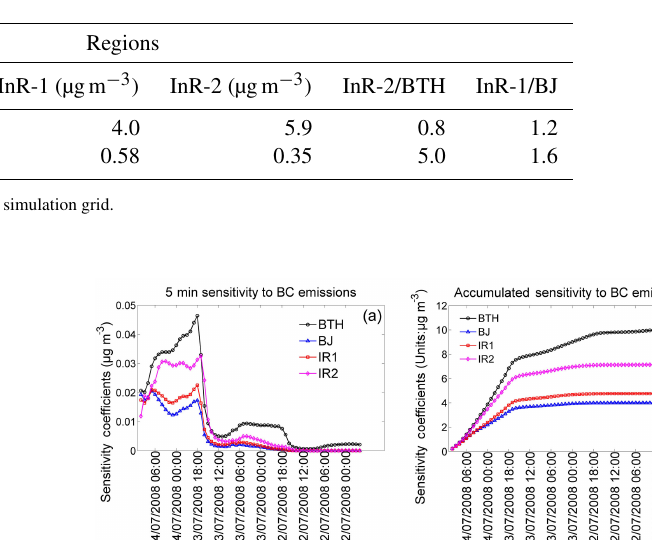
Table 4. 18h (17:00BT 3 July–11:00BT 4 July) cumulative SC and SC/Grid over the four emission reduction regions.